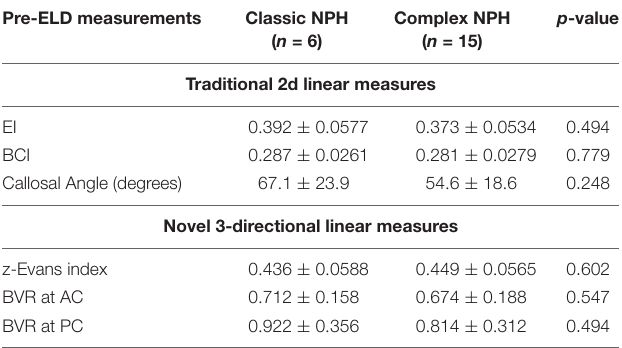
TABLE 4 | Intra-cohort comparisons of Classic vs. Complex normal pressure hydrocephalus (NPH) via baseline morphological indices. Pre-ELD